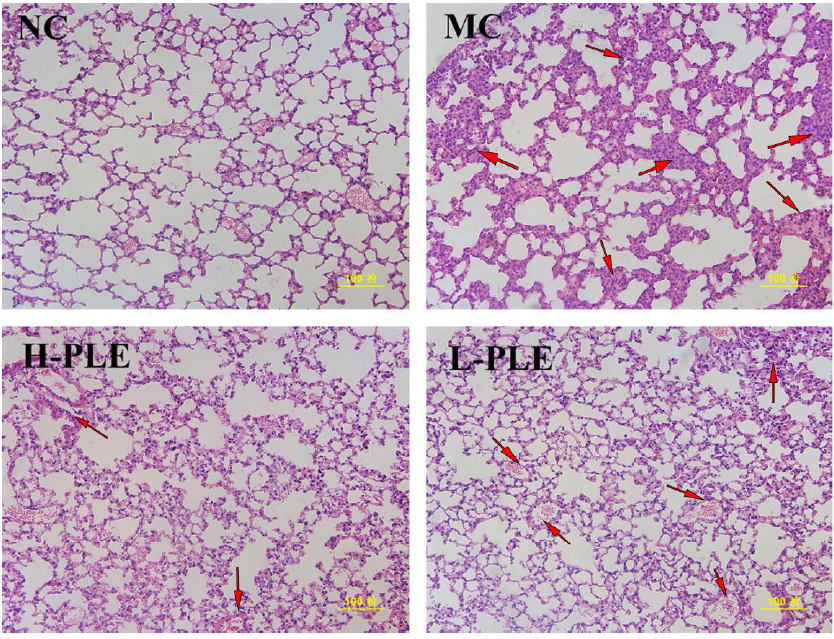
Figure 7. The histopathological observations of the lung by H&E staining (200×). NC: Normal control; MC: Model control; L-PLE: low dose group; H-PLE: high dose group. The red arrows represent neutrophils infiltrating the lung stroma with inflammatory cells and pulmonary telangiectasia with bleeding from cells.